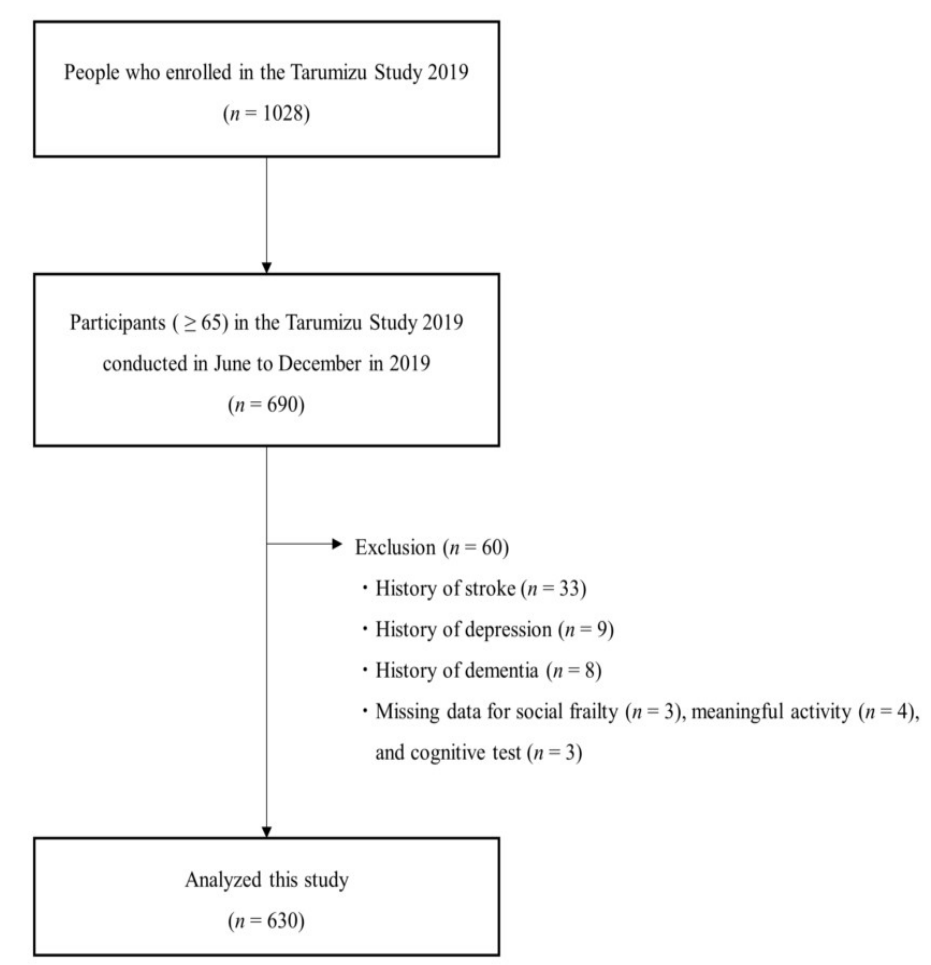
Figure 1. Flowchart for study inclusion and exclusion.